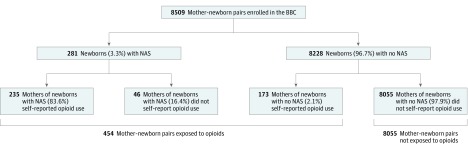
Flowchart of 8509 Mother-Newborn Pairs Enrolled in the Boston Birth Cohort (BBC)NAS indicates neonatal abstinence syndrome.